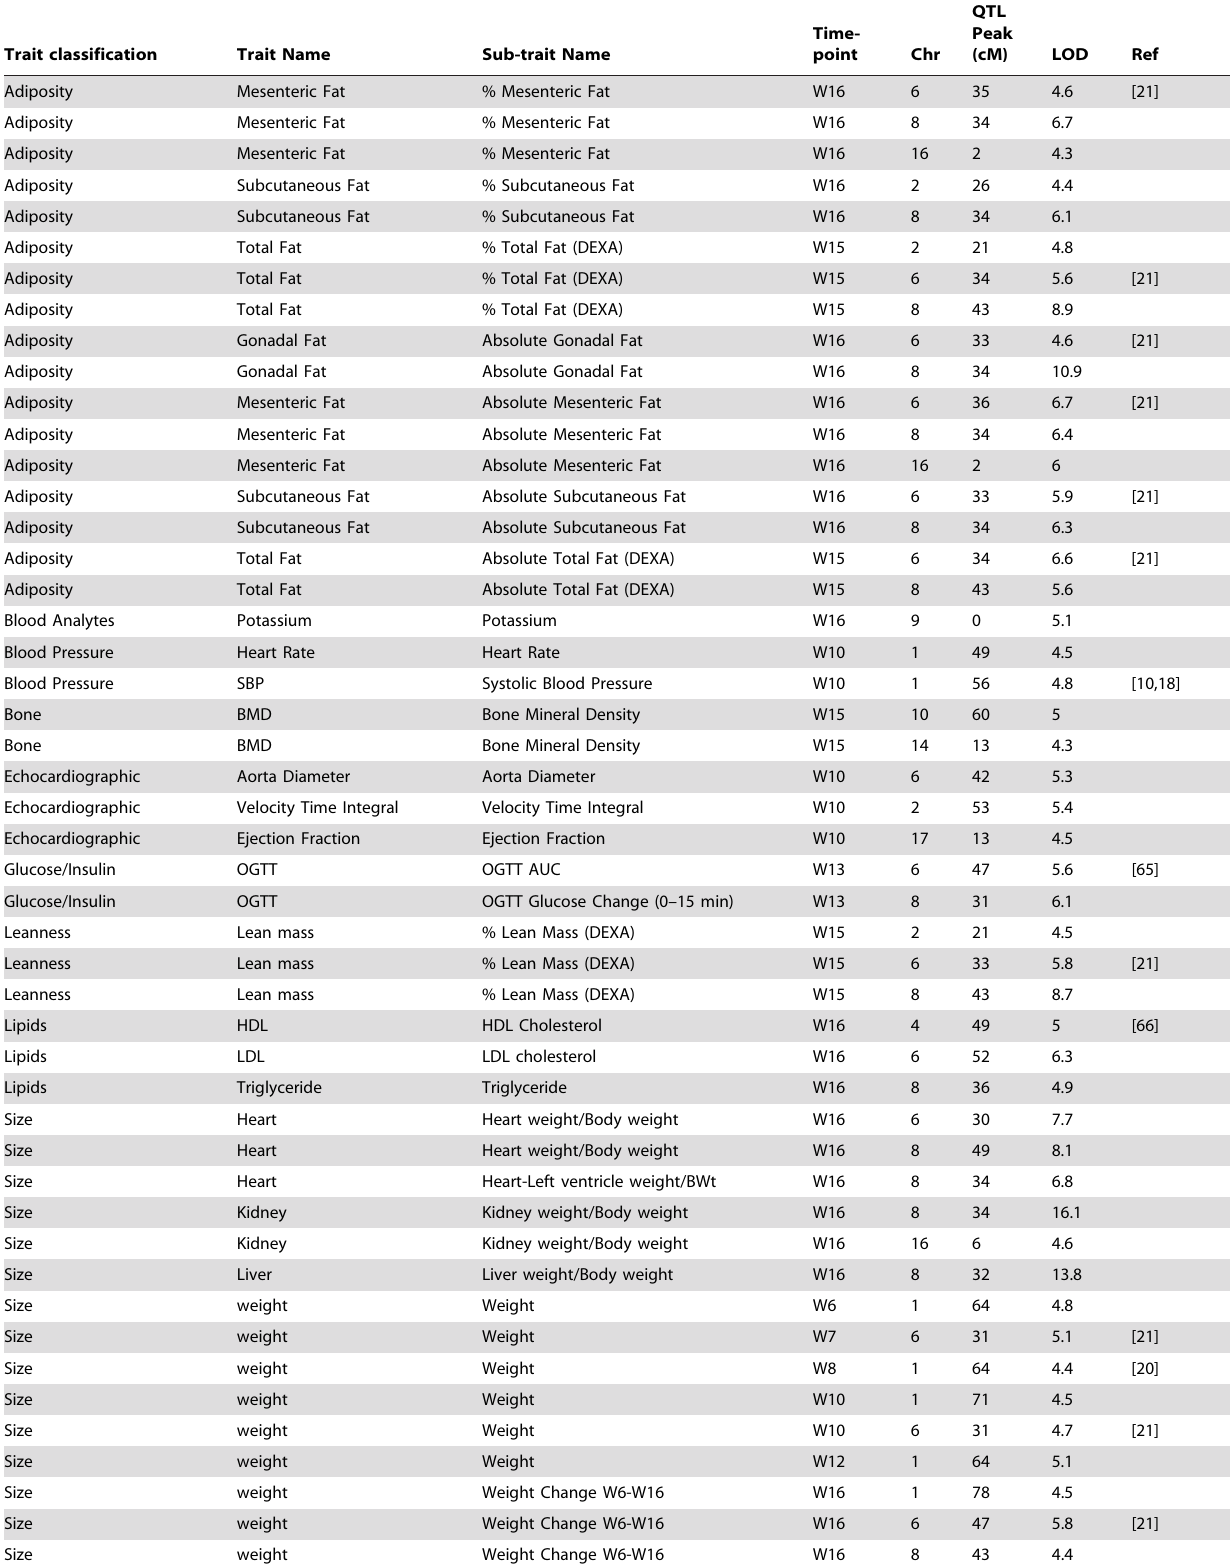
Table 1. Significant trait QTL mapped in the B6AF2 cohort.